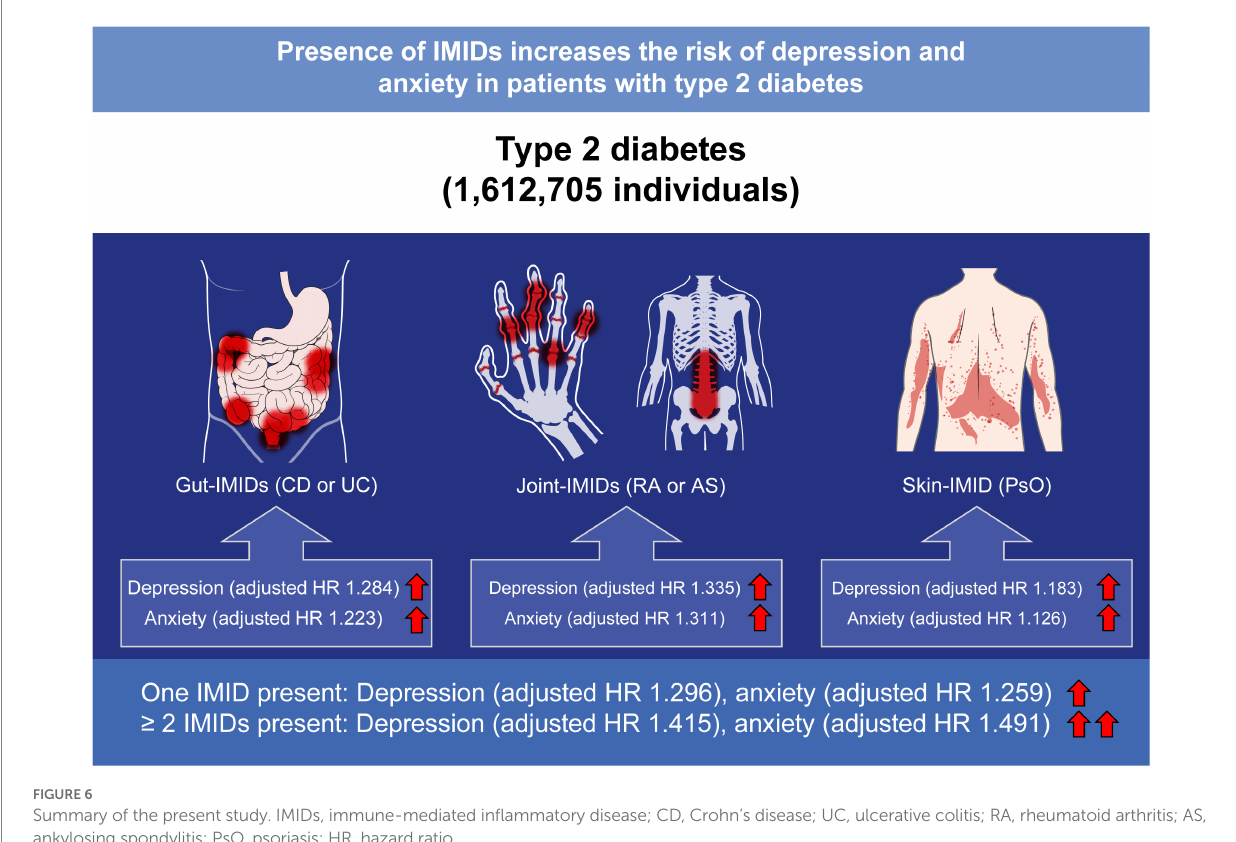
FIGURE 6 Summary of the present study. IMIDs, immune-mediated inflammatory disease; CD, Crohn’s disease; UC, ulcerative colitis; RA, rheumatoid arthritis; AS, ankylosing spondylitis; PsO, psoriasis; HR, hazard